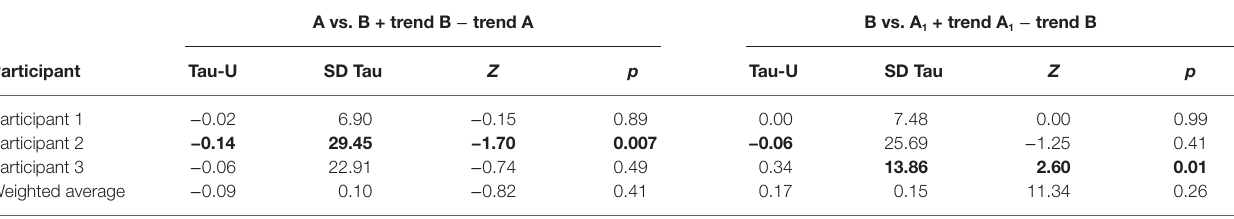
TABLE 1 | Tau-U calculations across phases for each